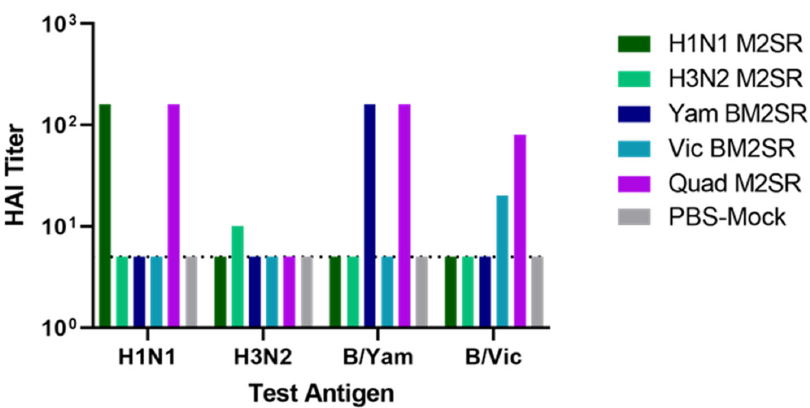
Figure 2. Serum antibody responses in mice following M2SR vaccination. Serum samples were collected from immunized mice 3 weeks following boost inoculation. HAI titers against analogous H1N1, H3N2, B/Yam, and B/Vic viral antigens were determined for pooled, RDE-treated sera. The HAI detection limit was five and is indicated by a dashed